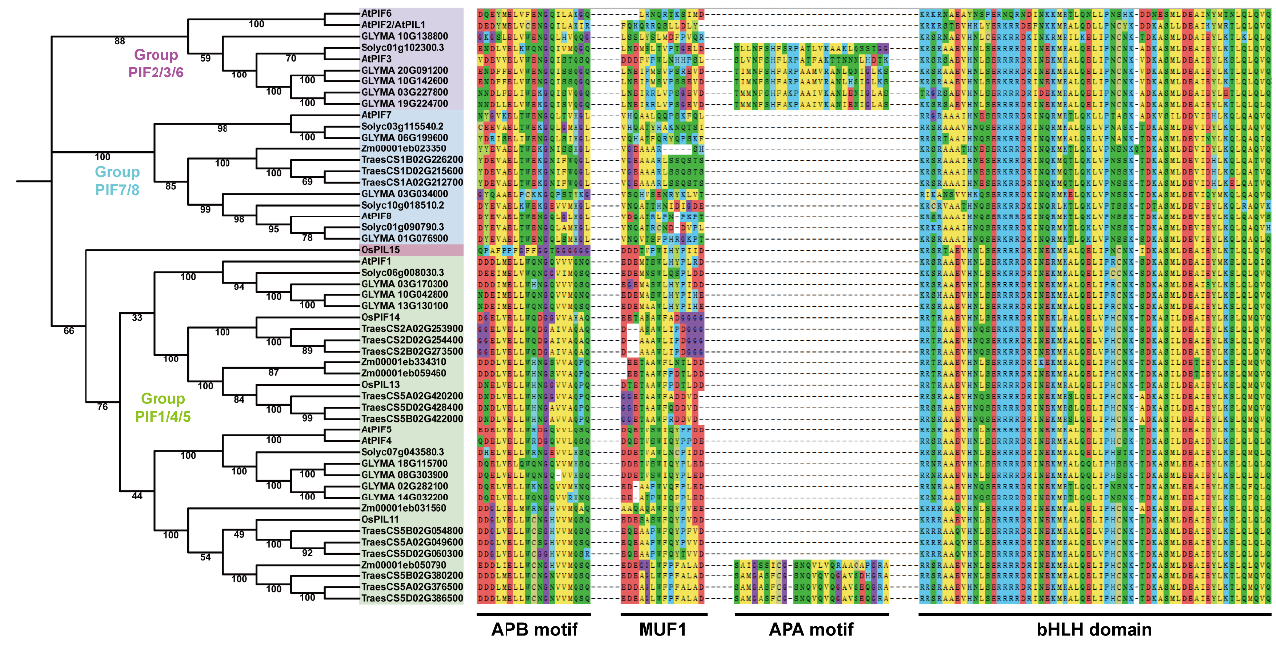
Figure 1. A neighbor-joining (NJ) phylogenetic tree of PIFs in Arabidopsis thaliana , Solanum lycoper- sicum , Glycine max , Triticum aestivum , Zea mays, and the Oryza sativa Japonica Group . The full-length protein sequences were used for the construction of a phylogenetic tree using MEGAX. The tree showed four major groups, which are indicated with different backgrounds. Multiple sequence alignment and motif analysis were performed using MEGAX and MEME.